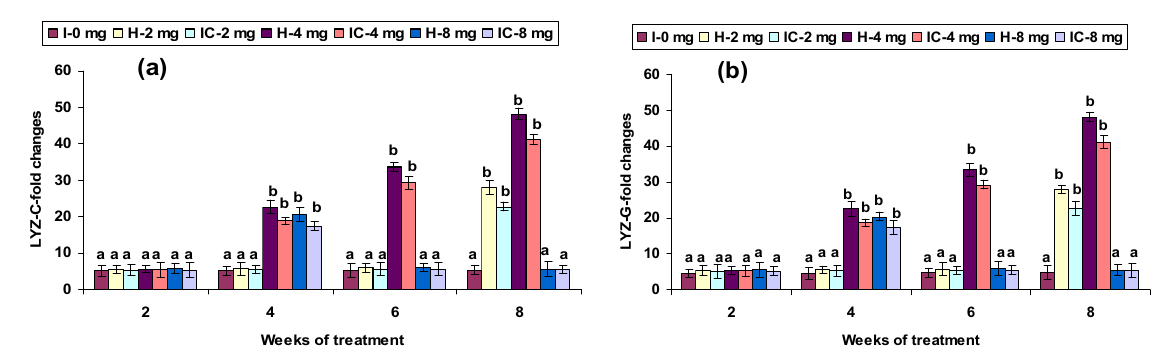
Figure 11. Expression pattern of ( a ) LYZ-C and ( b ) LYZ-G relative to β-actin in the head kidney of catla (n = 3) against A. hydrophila . H healthy, I infected. Values are expressed as mean ± SD and the statistical difference between means ( P < 0.05) indicated in different letters in each